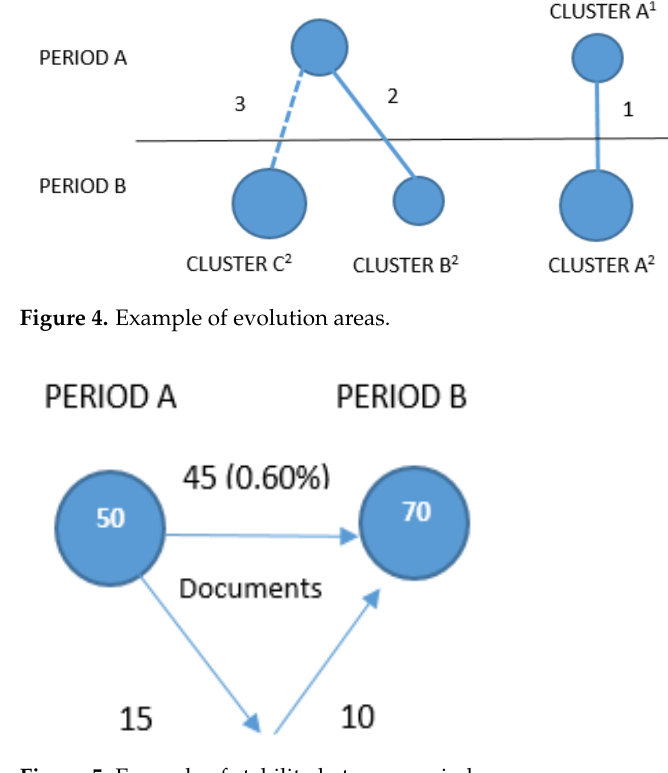
Figure 5. Example of stability between